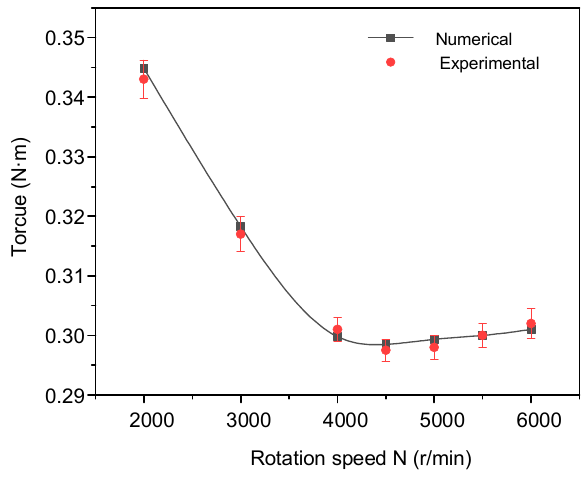
Figure 12. Variation in the friction torque with rotation speed.